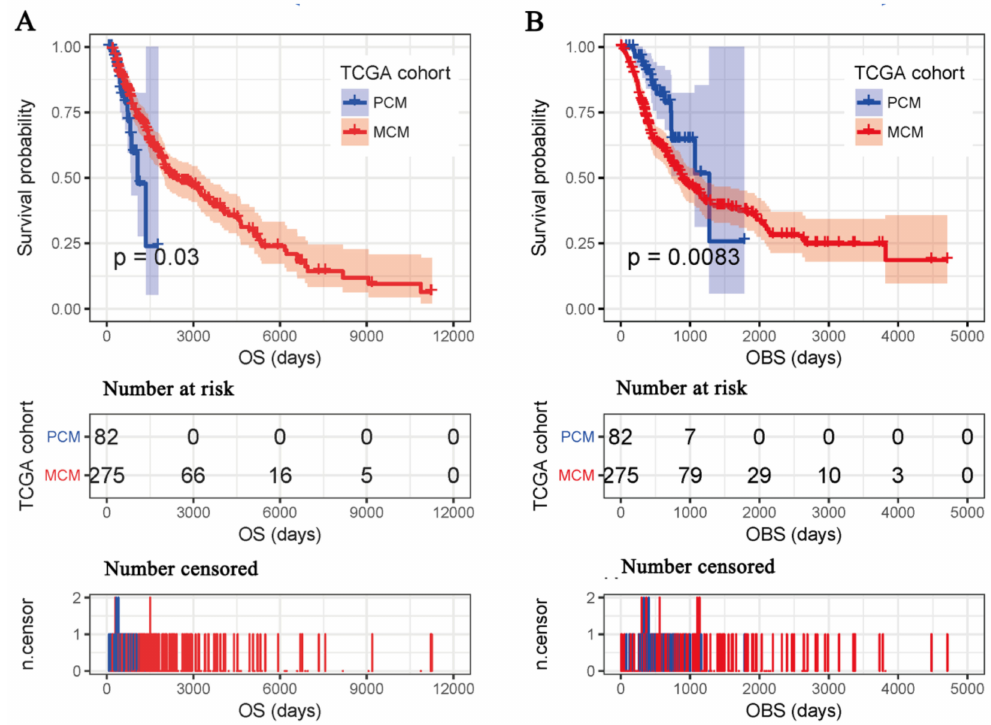
Figure 2. Kaplan-Meier survival analysis between PCM patients and MCM patients. PCM—primary SKCM; MCM—metastatic SKCM. OS ( A ) and the OBS ( B ) were considered clinical outcomes. The upper, middle, and lower parts represent the Kaplan-Meier plot, number of patients at risk for each group, and number of censored patients for each group respectively. OS—overall survival; OBS—observed survival